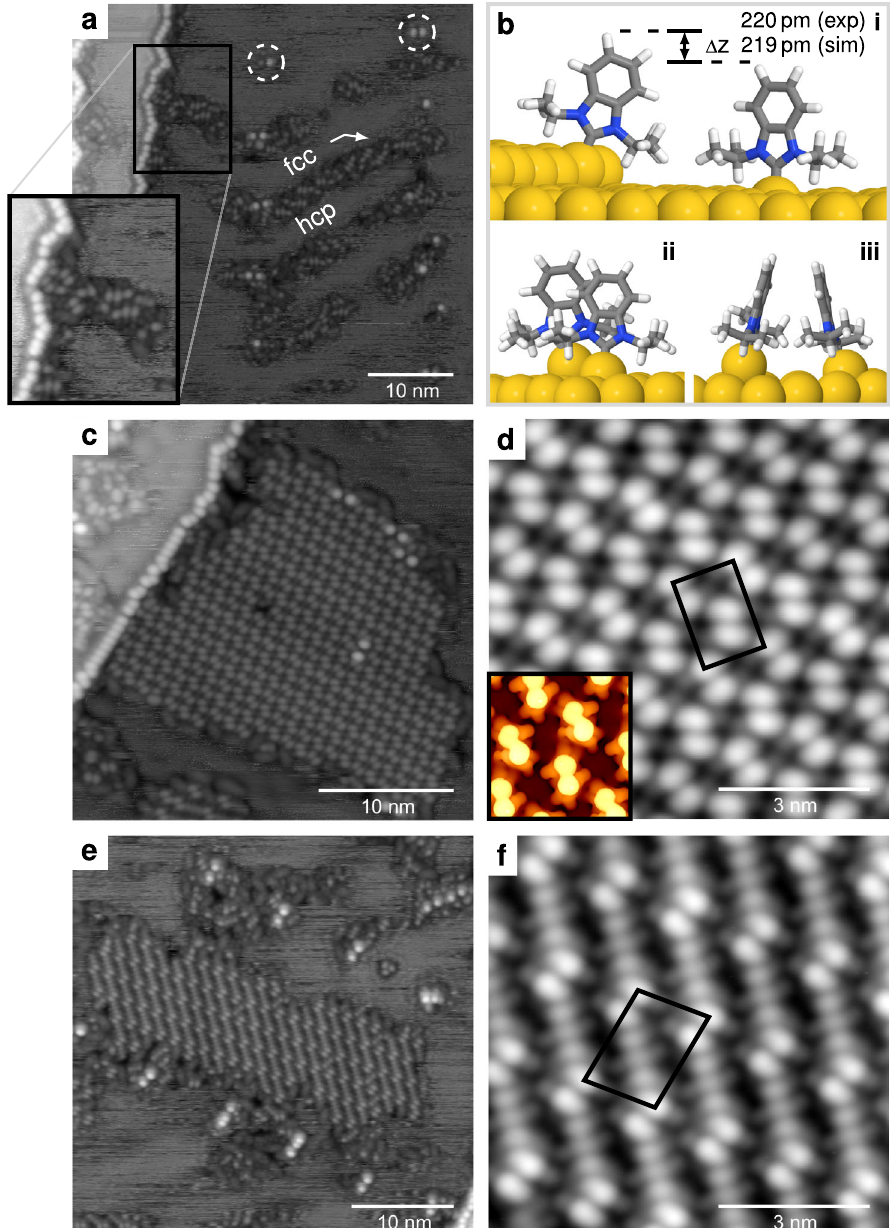
Fig. 2 Below the critical coverage required to form zig-zag arrays, NHC iPr preferentially binds to surface atoms. a In this regime, NHC iPr molecules preferentially occupy fcc regions of the herringbone reconstruction (20 pA, 100 mV, 48.0 × 48.0 nm 2 ). The inset highlights the STM height difference between NHCs attached to the step and those attached to the lower terrace. b Surface binding models showing (i) a surface-bound NHC next to an NHC at the step edge and (ii, iii) NHCs in the proposed surface-bound lattice. The simulated height difference between NHCs at the step edge and NHCs in the surface bound lattice (115 pm) and an isolated, surface-bound NHC (219 pm) are in good agreement with experiment (220 ± 10 pm). c Array of surface- bound NHCs on Au(111) (50 pA, 400 mV, 30.0 × 30.0 nm 2 ). d 8.0 × 8.0 nm 2 detail. e Exotic lattice of mixed surface-bound NHCs and (NHC) 2 Au complexes on Au(111) (20 pA, 100 mV, 40.0 × 40.0 nm 2 ). f 8.0 × 8.0 nm 2